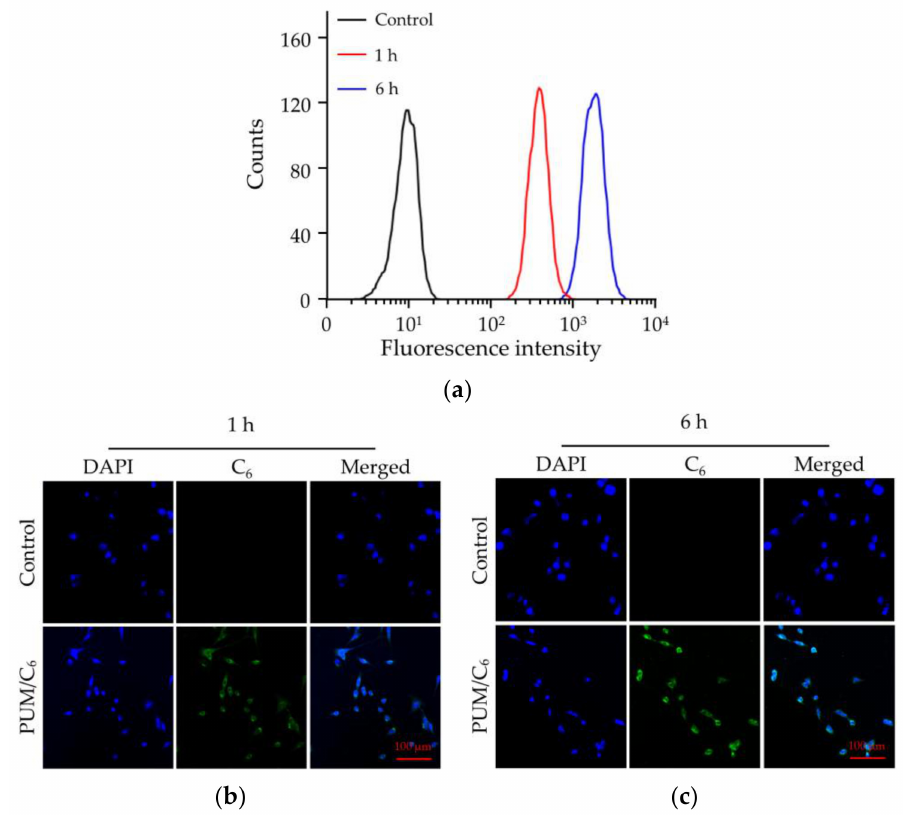
Figure 3. Cell uptake of PUM / C 6 after incubation with 4T1 cells detected by ( a ) flow cytometry (FCM) and ( b , c ) confocal laser scanning microscopy (CLSM) analyses in 1 h ( b ) and 6 h ( c ). PUM with HUBs was synthesized by the reversible reaction between cyclohexyl diisocyanate and tert -butyl